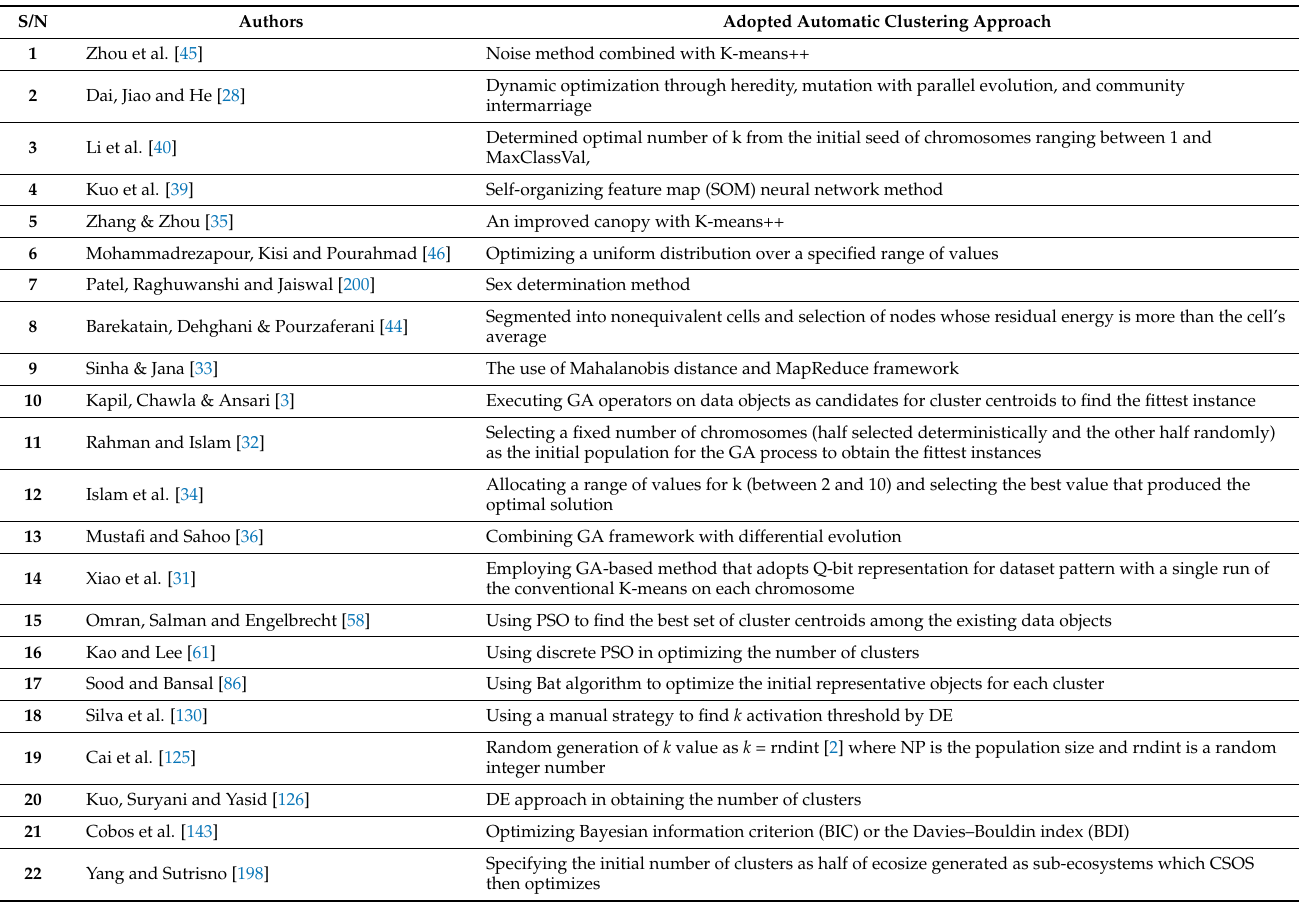
Table 2. List of adopted automatic clustering